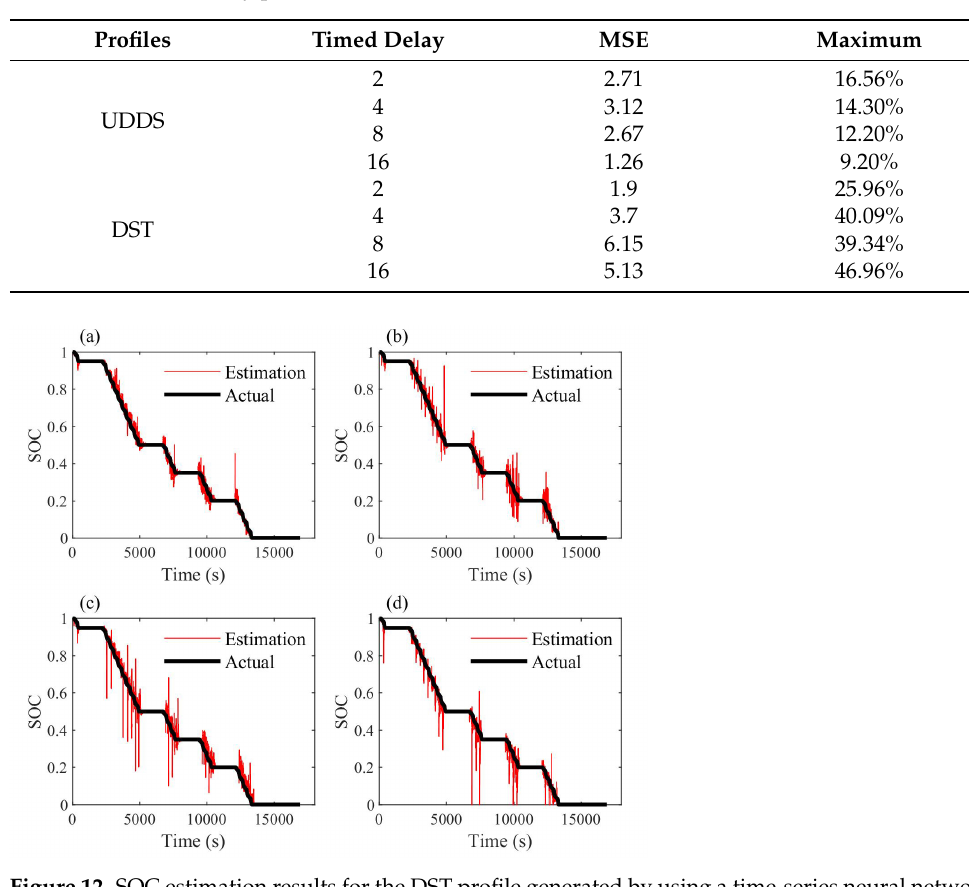
Figure 12. SOC estimation results for the DST profile generated by using a time-series neural network with different time delay parameters: ( a ) d = 2, ( b ) d = 4, ( c ) d = 8, and ( d ) d =